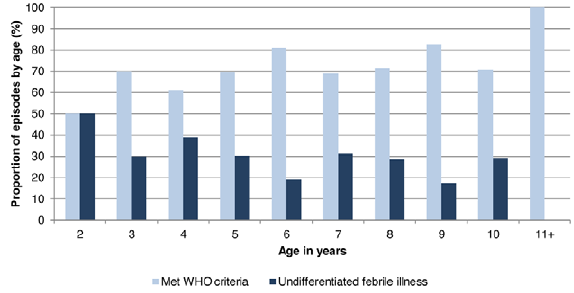
Figure 2. Frequency of dengue-positive episodes that met the WHO classification criteria for suspected dengue by age (n=181). Upon presentation to the health center or hospital, children with a febrile illness were classified according to whether or not they met the WHO classification criteria for suspected dengue. One patient had two dengue virus infections over the course of the study and is represented twice. n=6 for age 2, n=10 for age 3, n=18 for age 4, n=23 for age 5, n=21 for age 6, n=16 for age 7, n=21 for age 8, n=23 for age 9, n=24 for age 10, n=19 for age 11 + . Chi-square test for trend 5.977, p=0.01. WHO, World Health Organization.